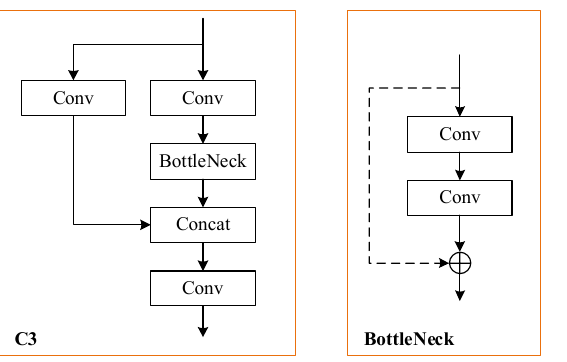
Figure 2. The structures of C3 and BottleNeck.